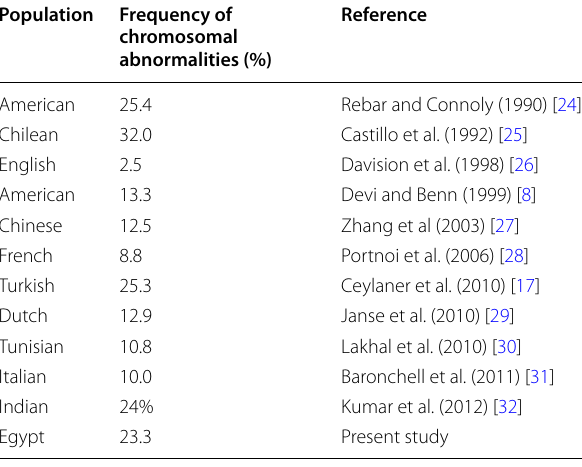
Table 6 Summary of frequency of chromosomal abnormalities in different population studies of